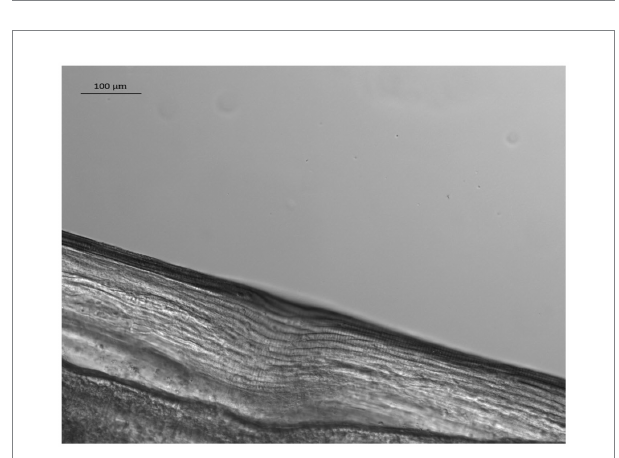
FIGURE 2 Longitudinal cuticular ridges of Dirofilaria repens adult in